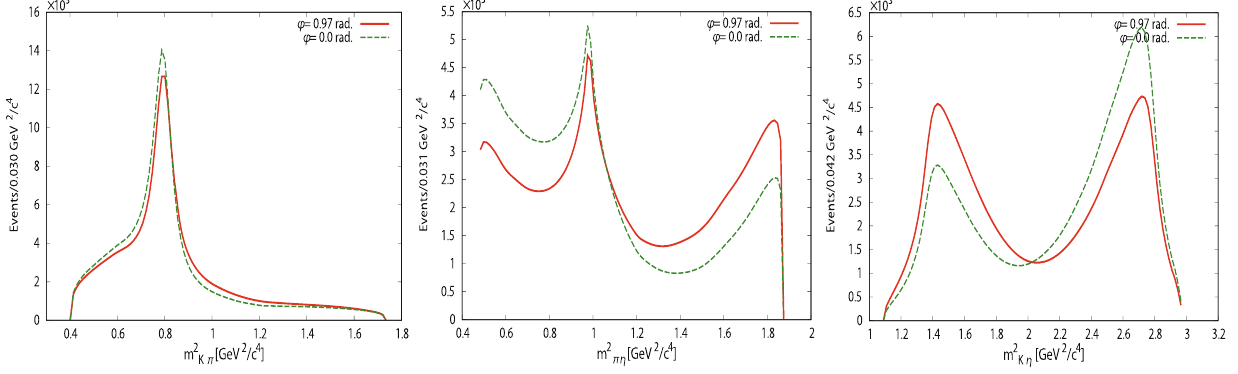
Fig. 12 Effect on the three mass distributions of the different phase